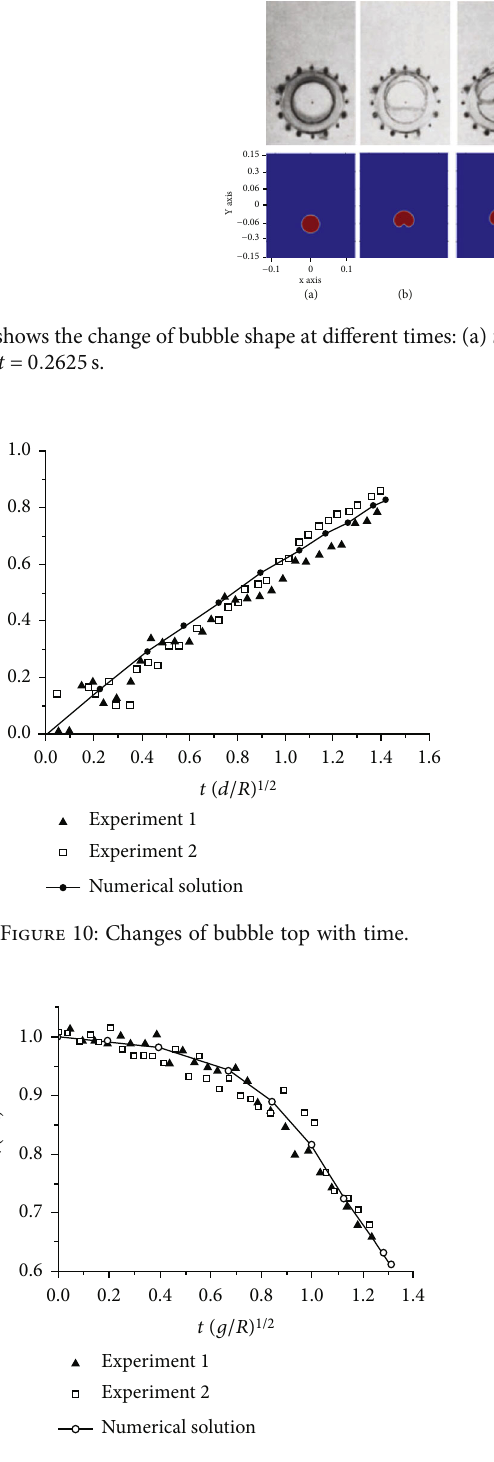
Figure 11: Changes of bubble thickness with